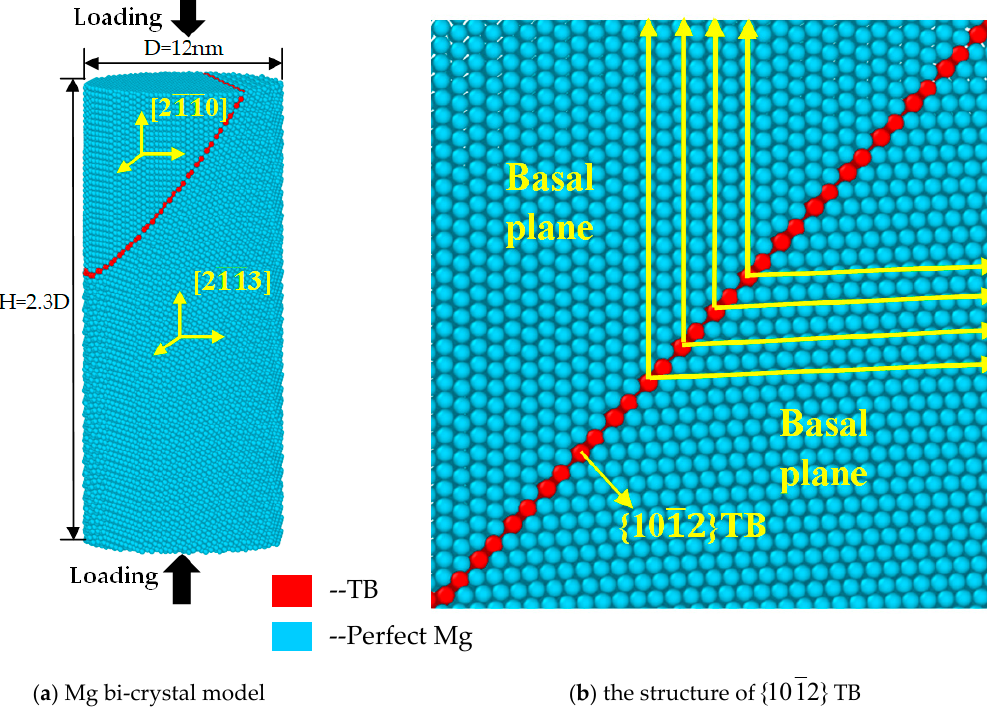
Figure 1. Atomic configurations of Mg bi-crystal nanopillars with { 1012 } twin boundary (TB). Blue solid circles indicate perfect Mg atoms, while red ones at the { 1012 } TB.